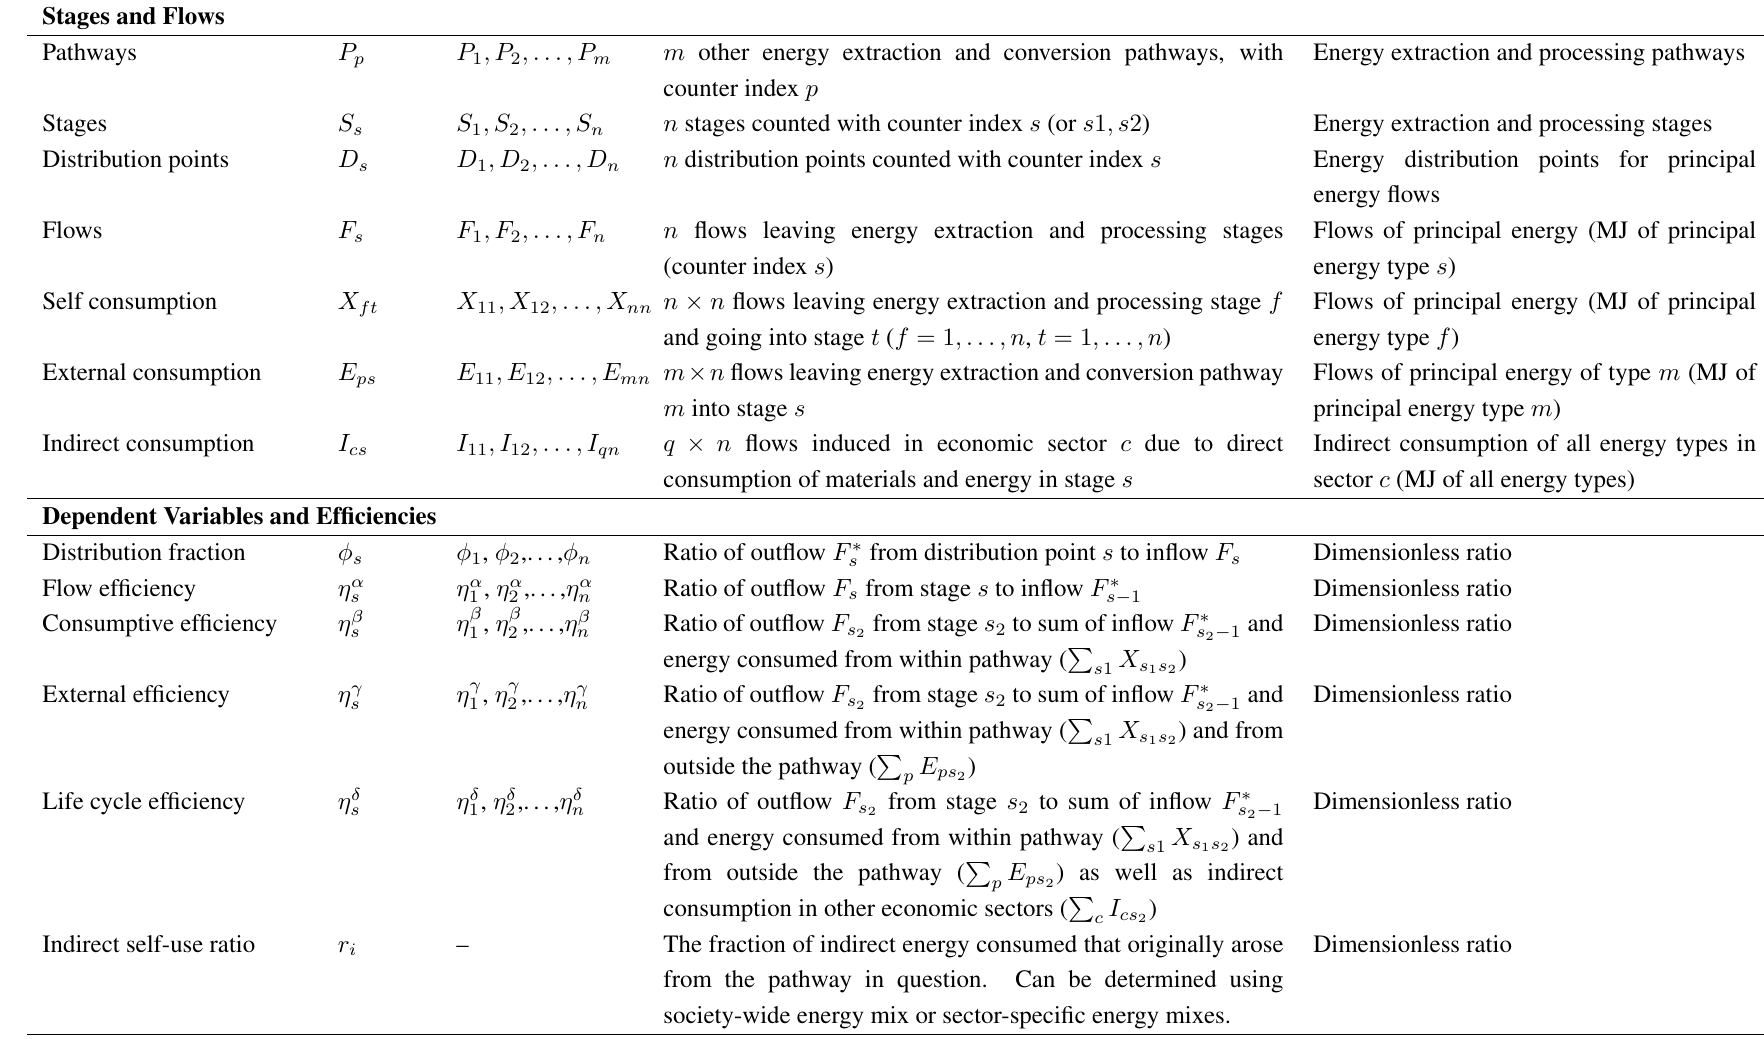
Table 3. Definitions of model terms for quantities with magnitudes and dimensionless